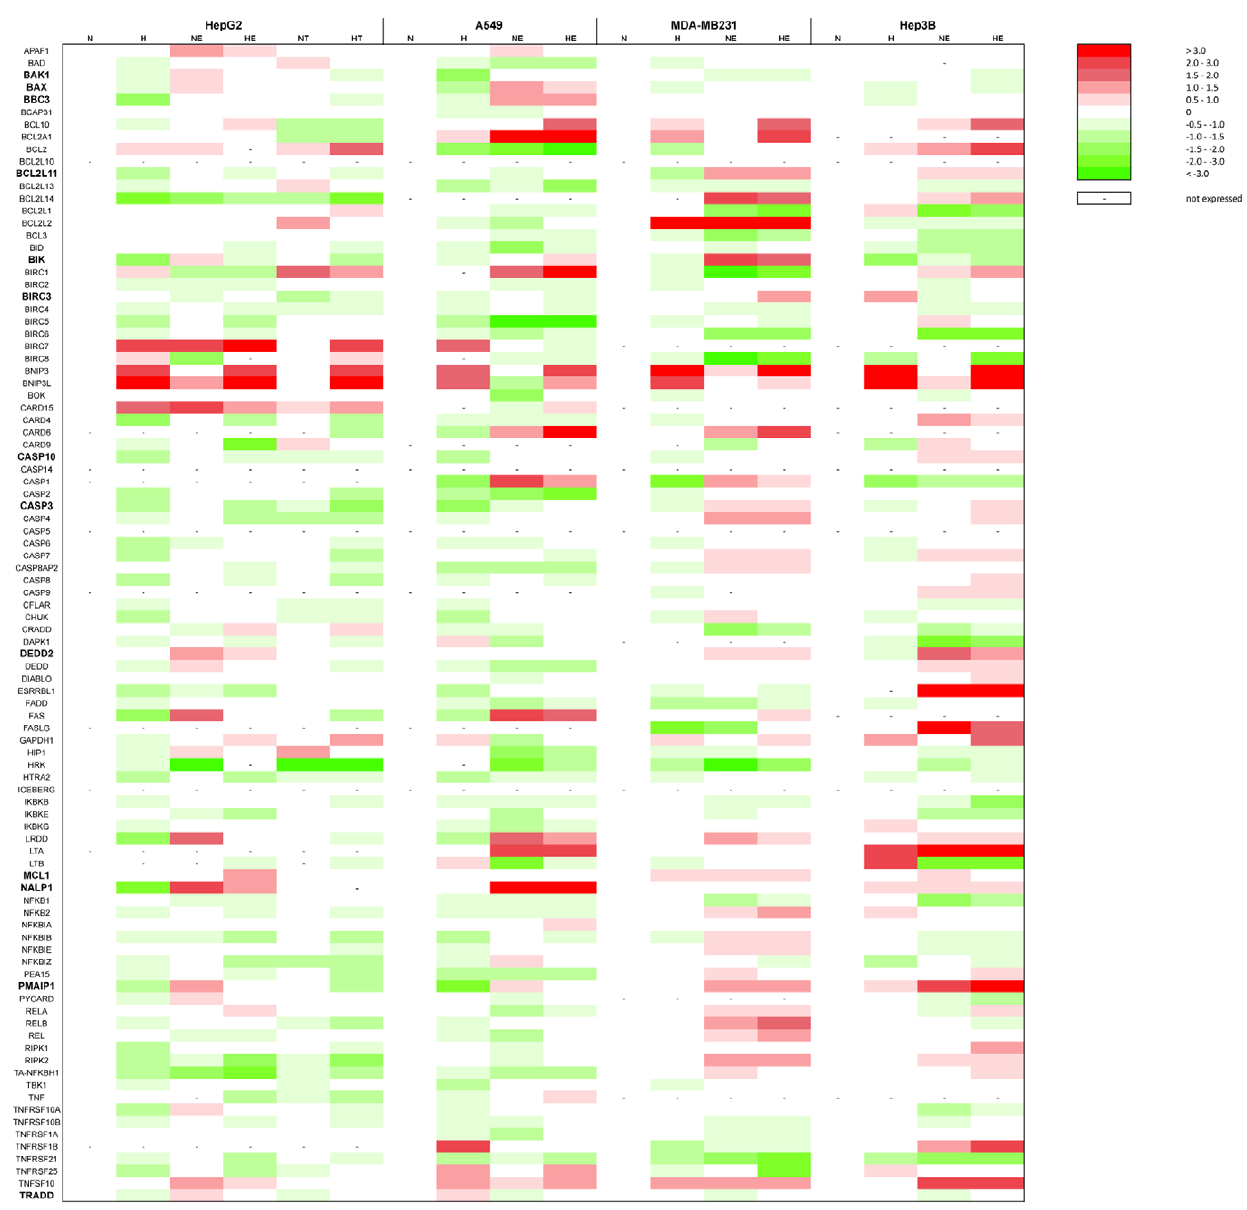
Figure 4. Effect of hypoxia, etoposide and paclitaxel on the mRNA expression level of genes involved in the apoptotic pathway. Results were obtained using ‘‘TLDA Human Apoptosis Panel’’ (Applied Biosystems) (TLDA). HepG2, A549, MDA-MB231 and Hep3B cells were incubated 16 hours under normoxia (N, 21% O 2 ) or hypoxia (H, 1% O 2 ) in the presence or not of etoposide (E, 100 m M in Hep3B cells and 50 m M in the other cell types) or paclitaxel (T, 10 m M) in HepG2 cells. After incubation, total RNA was extracted, submitted to reverse transcription and then to TLDA analysis. 18S was used as housekeeping gene for data normalization. Actual numerical values are provided in Table S2. Genes shown in bold are genes whose expression was validated by